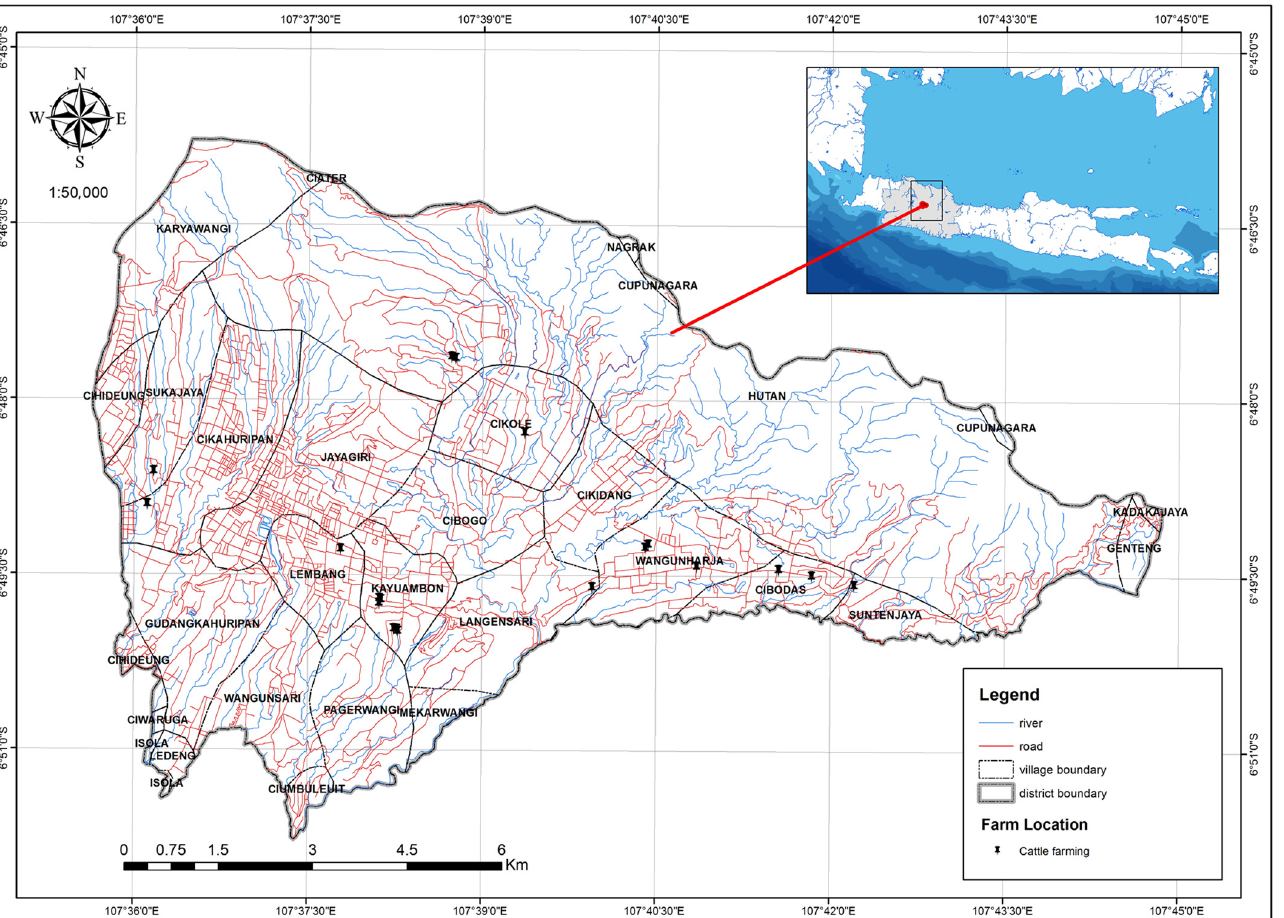
Figure 1. Map of cow manure sampling locations.